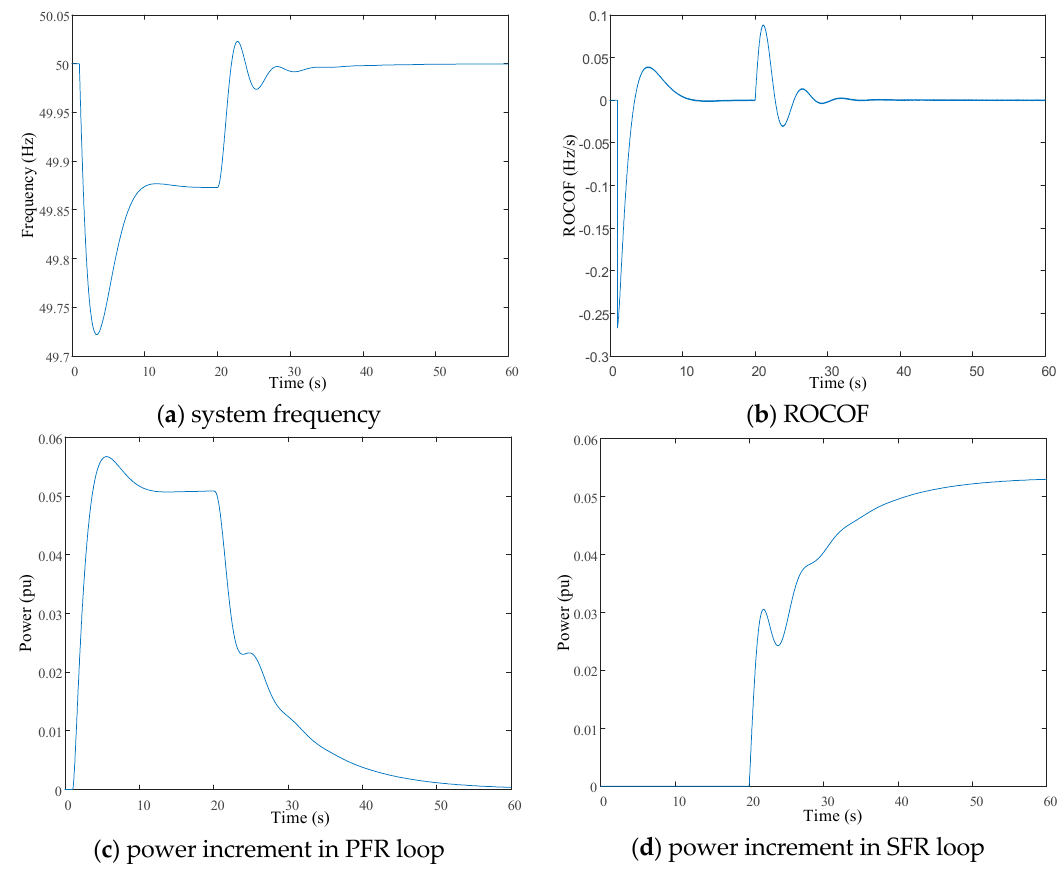
Figure 8. Simulation of SFR for a step change of load.